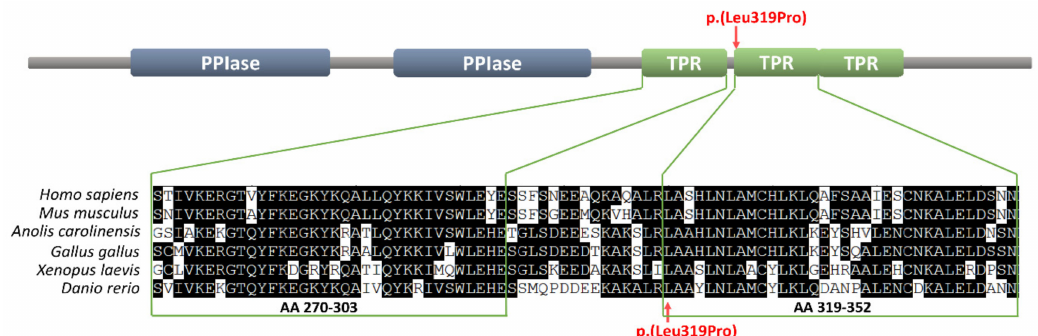
Figure 2. The Leu319 position within the tetratricopeptide repeat (TPR) domain of the FKBP4 protein and the conservation of that residue among vertebrates from fish to humans. The upper part represents the FKBP4 protein domains organization (PPIase = prolyl isomerase). The lower part represents the alignment of the first two human TPR repeats of human, mouse, lizard, chicken, frog, and zebrafish homologues. The FKBP4:p.Leu319Pro mutation is indicated with